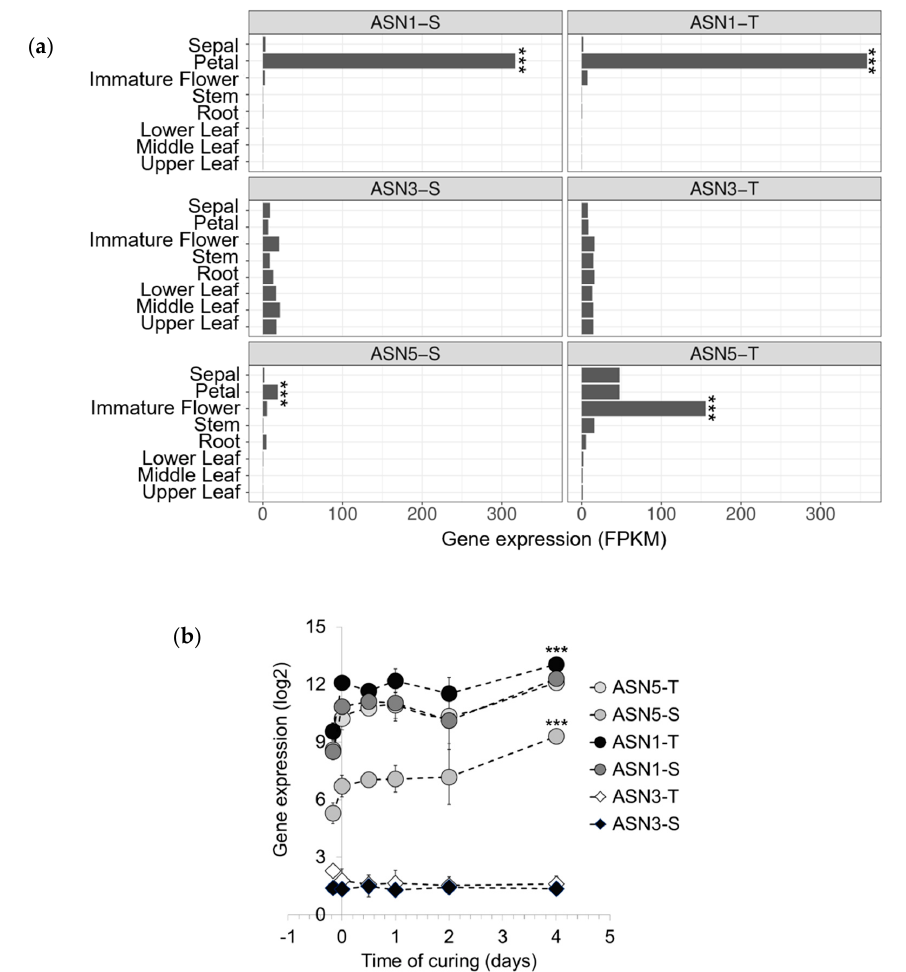
Figure 3. ( a ) Expression of asparagine synthetase (ASN) genes in different organs of burley tobacco. Tissue samples, including the sepal, petal, immature flower stem, root, and leaf in lower, middle, and upper positions, were collected from burley TN90 tobacco plants at flowering stage when lower leaves just started to senesce and became ready for curing, and were then used for RNA-seq analysis. Each bar represents the averaged FPKM (Fragments Per Kilobase of exon per Million fragments mapped) values corresponding the relative expression levels of the gene. Data were collected from three biological replicates and analyzed by p values adjusted for false discovery rate. Asterisks indicate statistical significance when comparing expression levels among tissues (n = 3, ***p < 0.001). ( b ) Time course of the air curing effect on the asparagine synthetase (ASN) gene expression in burley tobacco leaves. The expression patterns of ASN genes ( ASN1-S, ASN1-T, ASN3-S, ASN3-T, ASN5-S, and ASN5-T ) were followed at early stages of air curing (1 to 4 days post-harvest). Data were collected from three biological replicates. Each datapoint represents the mean of gene expression (in log2) estimated by using the Affymetrix Tobacco exon array in accordance with Martin et al. [39]. Vertical bars are standard deviation (SD).